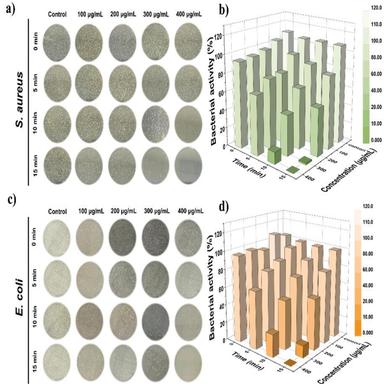
Antibacterial performance of Fc-PP-POP at different concentrations and different irradiation times. a) Photographs of S. aureus at different concentrations of Fc-PP-POP and different laser irradiation times; b) Corresponding bacterial viability after treatment in different groups (n = 3); c) Photographs of E. coli at different concentrations of Fc-PP-POP and different laser irradiation times; d) Corresponding bacterial viability after treatment in different groups (n = 3).